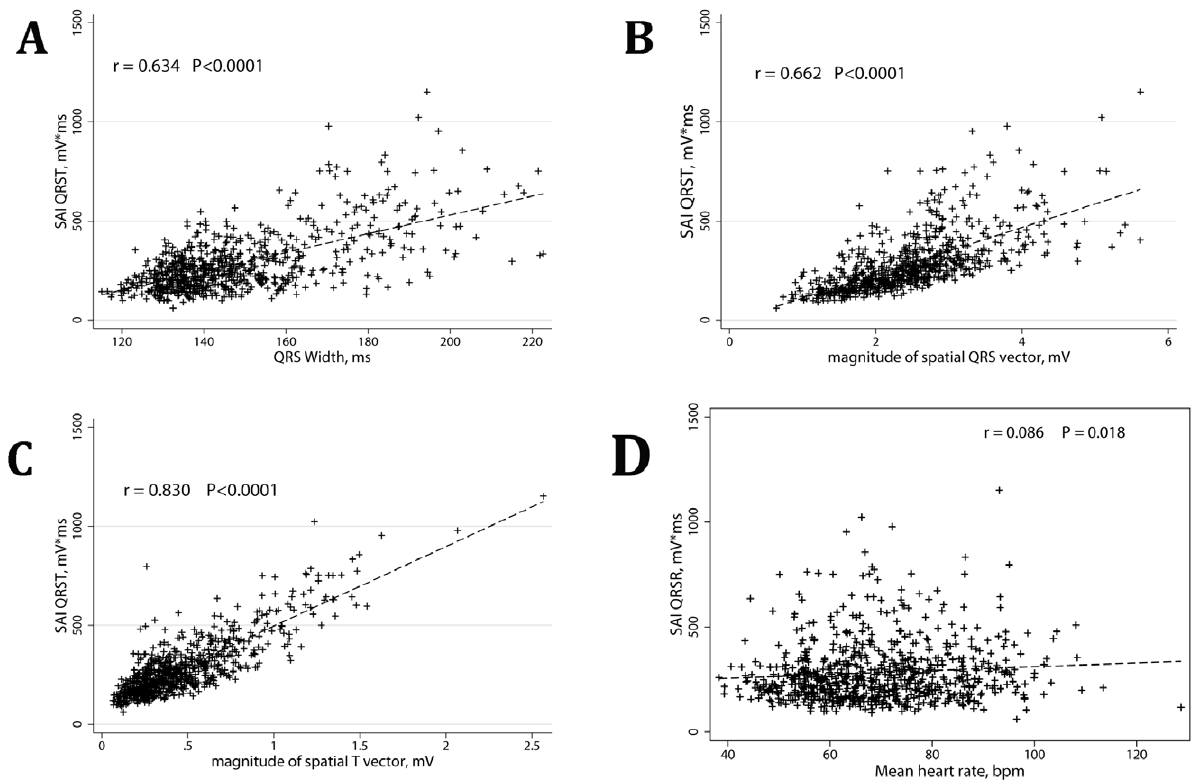
Figure 1. Correlations between QRS width and SAI QRST (A), between mean magnitude of spatial QRS vector and SAI QRST (B), between mean magnitude of spatial T vector and SAI QRST (C), and between mean heart rate and SAI QRST (D). Linear regression fitted line is shown in each graph. doi:10.1371/journal.pone.0051812.g001 PLOS ONE |